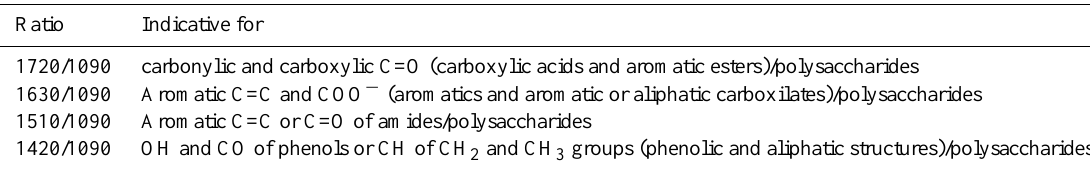
Table 1. Overview of calculated FTIR ratios as a humification index according to Beer et al. (2008) and attribution of structural units in organic matter FTIR-spectra after Niemeyer et al. (1992) and Senesi et al.